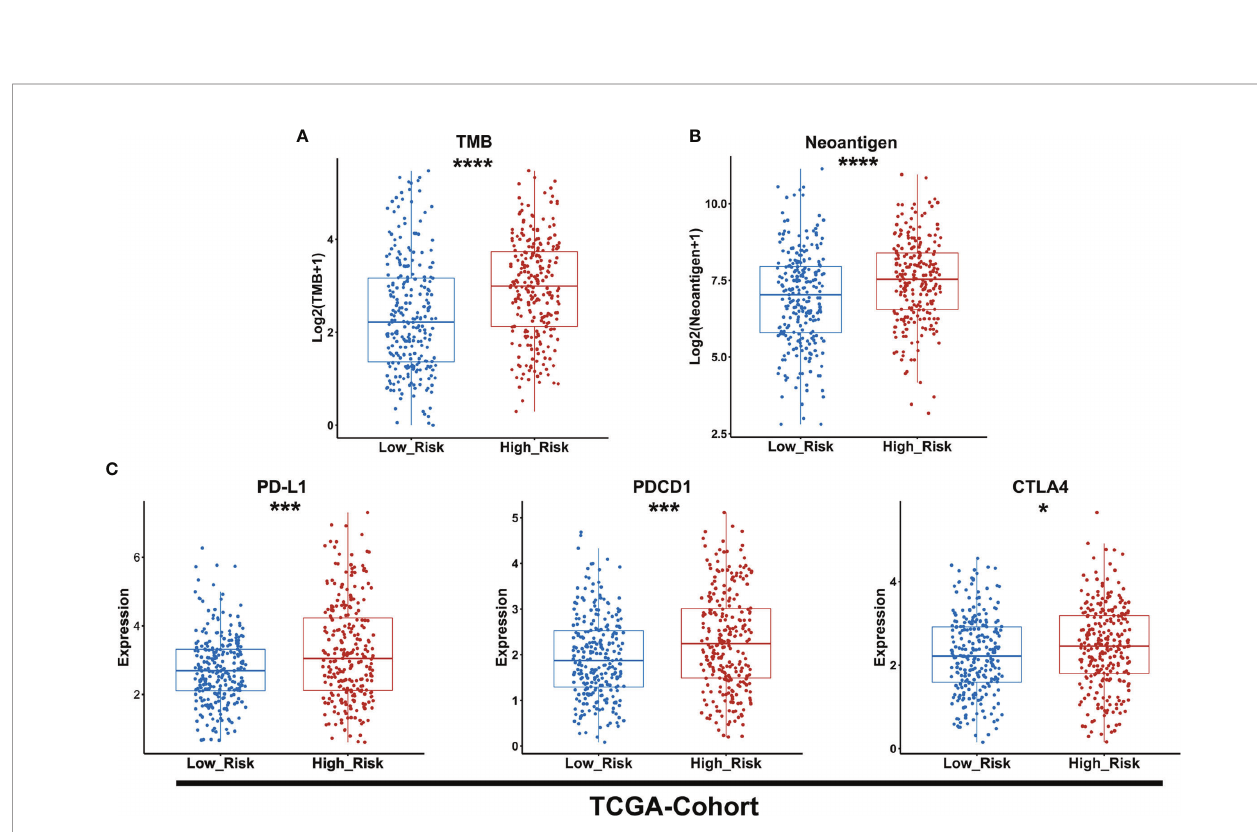
FIGURE 6 | The high-risk group exhibits a higher level of TMB and neoantigen as well as PD-L1, PDCD1, and CTLA4 expression than the lower-risk group. (A, B) Boxplot of TMB and neoantigen between low and high-risk groups of the TCGA cohort. (C) Statistical analysis of the expression of PD-L1, PDCD1, CTLA4 between low- and high-risk groups in TCGA cohort. *P < 0.05; ***P < 0.001; ****P <